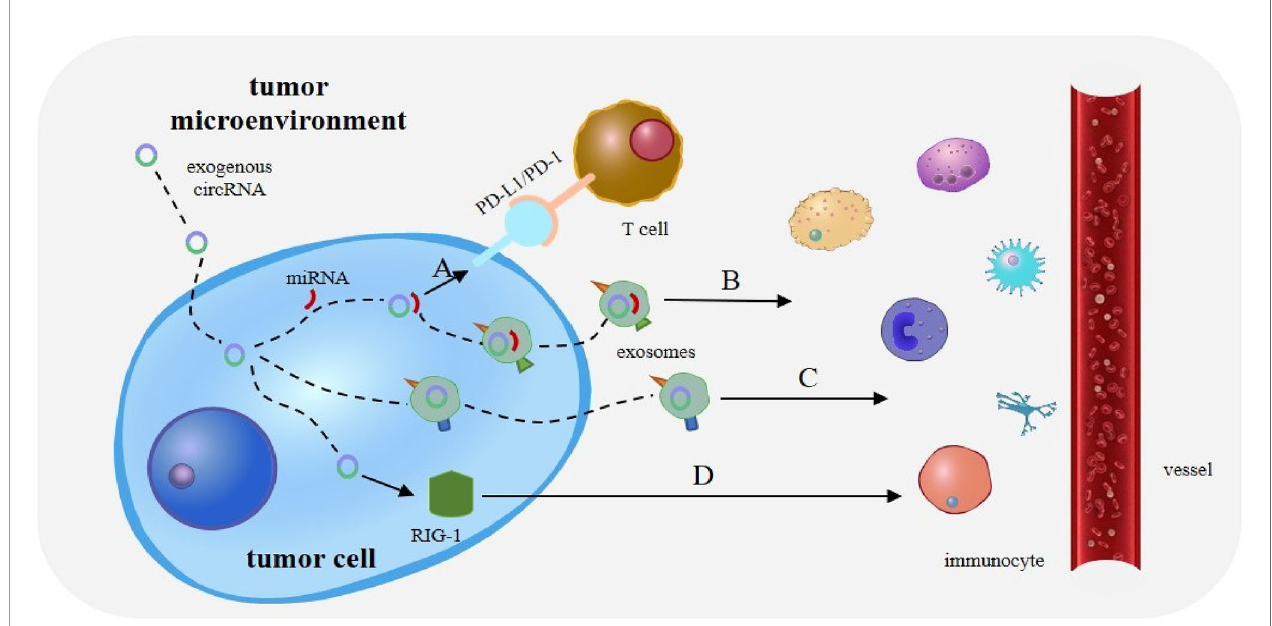
FIGURE 3 | Role of circRNAs in tumor immunity. (A) The interaction between programmed death receptor 1 (PD-1) and programmed cell death ligand 1 (PD-L1) can effectively suppress the activation of effector T lymphocytes, ultimately leading to tumor immune escape. (B) CircRNA can also bind tumor-speci fi c miRNAs and mRNAs through complementary sequences, to form a novel tumor antigen. CircRNA exists in exosomes to enhance the stability of these RNAs and is released upon reaching the target immune cells. (C) Exosomes and extracellular vesicles (EVs) can transport circRNA into immune cells. CircRNA can then act as potential tumor antigens to regulate immune responses in tumors. (D) Exogenous circRNA entering tumor cells may activate antitumor immunity by in fl uencing